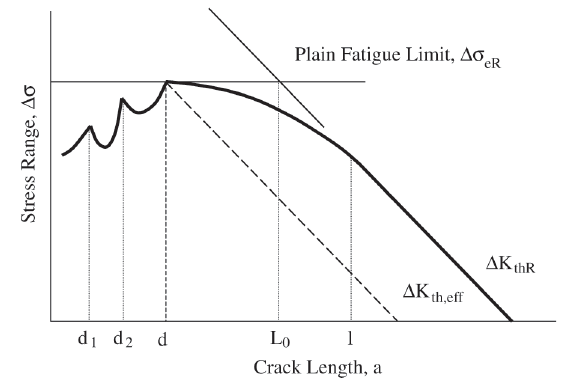
Figure 1. Material crack growth threshold as a function of the crack length, showing the border between propagating and non- propagating